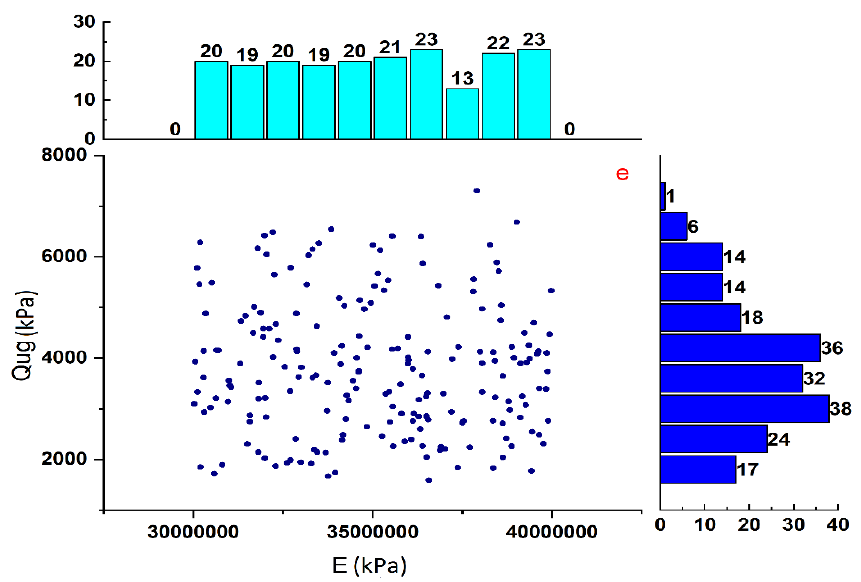
Figure 6. Marginal plot for the pile group capacity ( Qug ) with ( a ) qc 0, ( b ) qc 1, ( c ) qc 2, ( d ) qc , and ( e ) E .